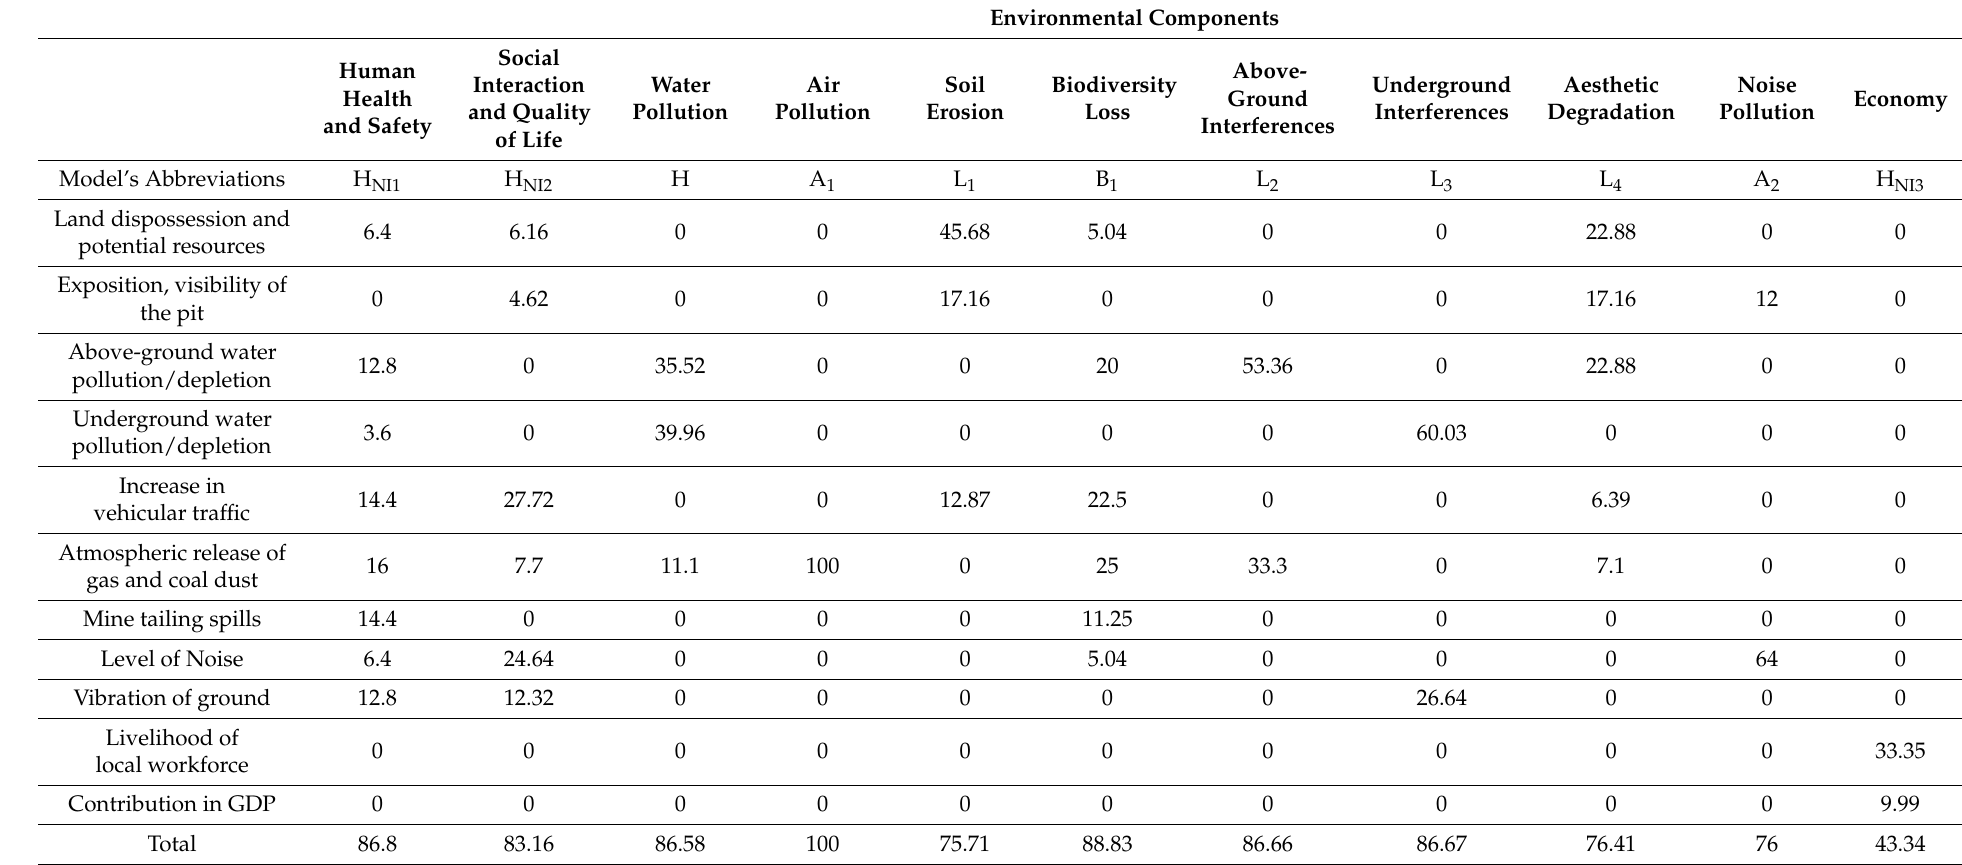
Table 4. Final weighted impact scores of Sindh Engro coal